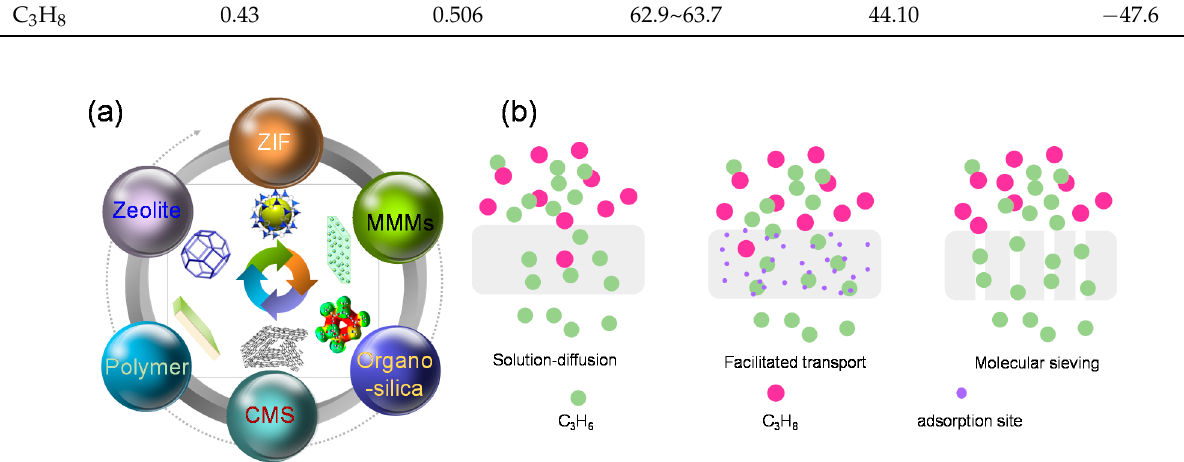
Figure 1. ( a ) Overview of the various membrane materials for C 3 H 6 /C 3 H 8 separation. ( b ) General permeation mechanisms for C 3 H 6 /C 3 H 8 separation through membranes.